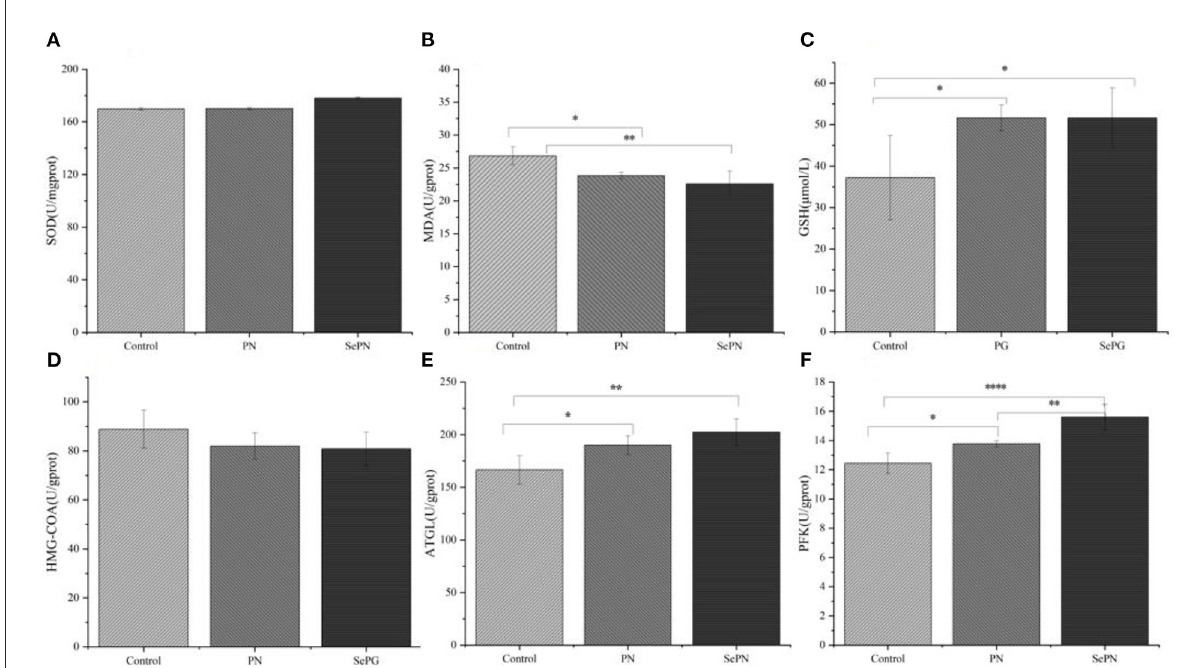
FIGURE3 Antioxidant and enzyme activities of glucolipid metabolism in the liver. (A) Liver superoxide dismutase (SOD) levels. (B) Liver malondialdehyde (MDA) levels. (C) Liver glutathione (GSH) levels. (D–F) Effects of PN/SePN on liver hydroxymethylglutaryl CoA reductase (HMG-CoAR), adipose triglyceride lipase (ATGL), and phosphofructokinase (PFK). Data are expressed as mean ± SD. * P < 0.05, ** P < 0.01, *** P < 0.001, and **** P < 0.0001 compared with the control group ( n =